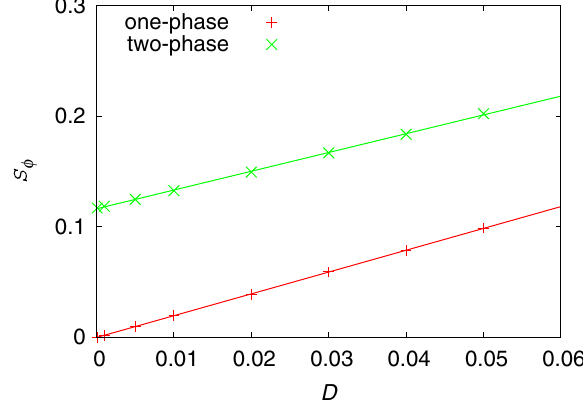
FIG. 2. Total entropy production S ϕ for Active Model B in one dimension for the case where the system consists of a single uniform phase ( a 2 > 0 , a 4 > 0 , red line) and for the case where it shows coexistence between a high-density and a low-density phase ( a 2 < 0 , a 4 > 0 , green line). [Parameter values are a 2 ¼ (cid:3) 0 . 25 for the uniform ðþÞ and phase-separated ð − Þ states, with a 4 ¼ 0 . 25 , κ ¼ 4 , λ ¼ 1 .] In the two-phase system, any putative ffiffiffiffi p D subextensive (interfacial) term scaling as would be swamped by the extensive D 1 contribution from bulk phases.